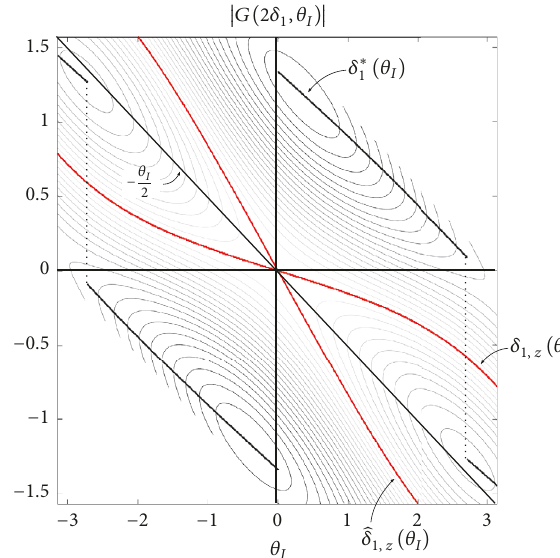
Figure 9: Contour plot of the |𝐺|